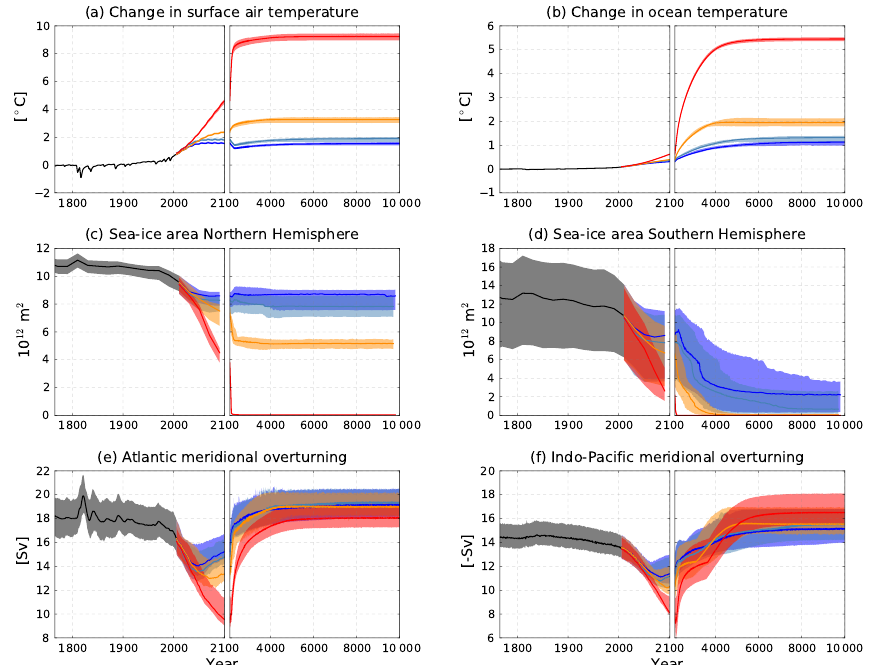
Figure 1. Temporal evolution of physical variables relative to 1870–1899 for model ensembles aiming at 1.5, 1.9, 3.3 and 9.2 ◦ C warming targets. Lines mark the median and shading marks the 90% range of the ensemble. The shading reflects uncertainties due to variations in the diapycnal mixing coefficient. (a) Displays the changes in surface air and (b) displays the changes in ocean mean temperatures. (c,) and (d) are annual mean sea-ice areas in the respective hemisphere. (e) Atlantic meridional overturning is the maximum of the Atlantic meridional overturning stream function below 400m depth and (f) Indo-Pacific meridional overturning is the minimum of the Indo-Pacific meridional overturning stream function below 400m